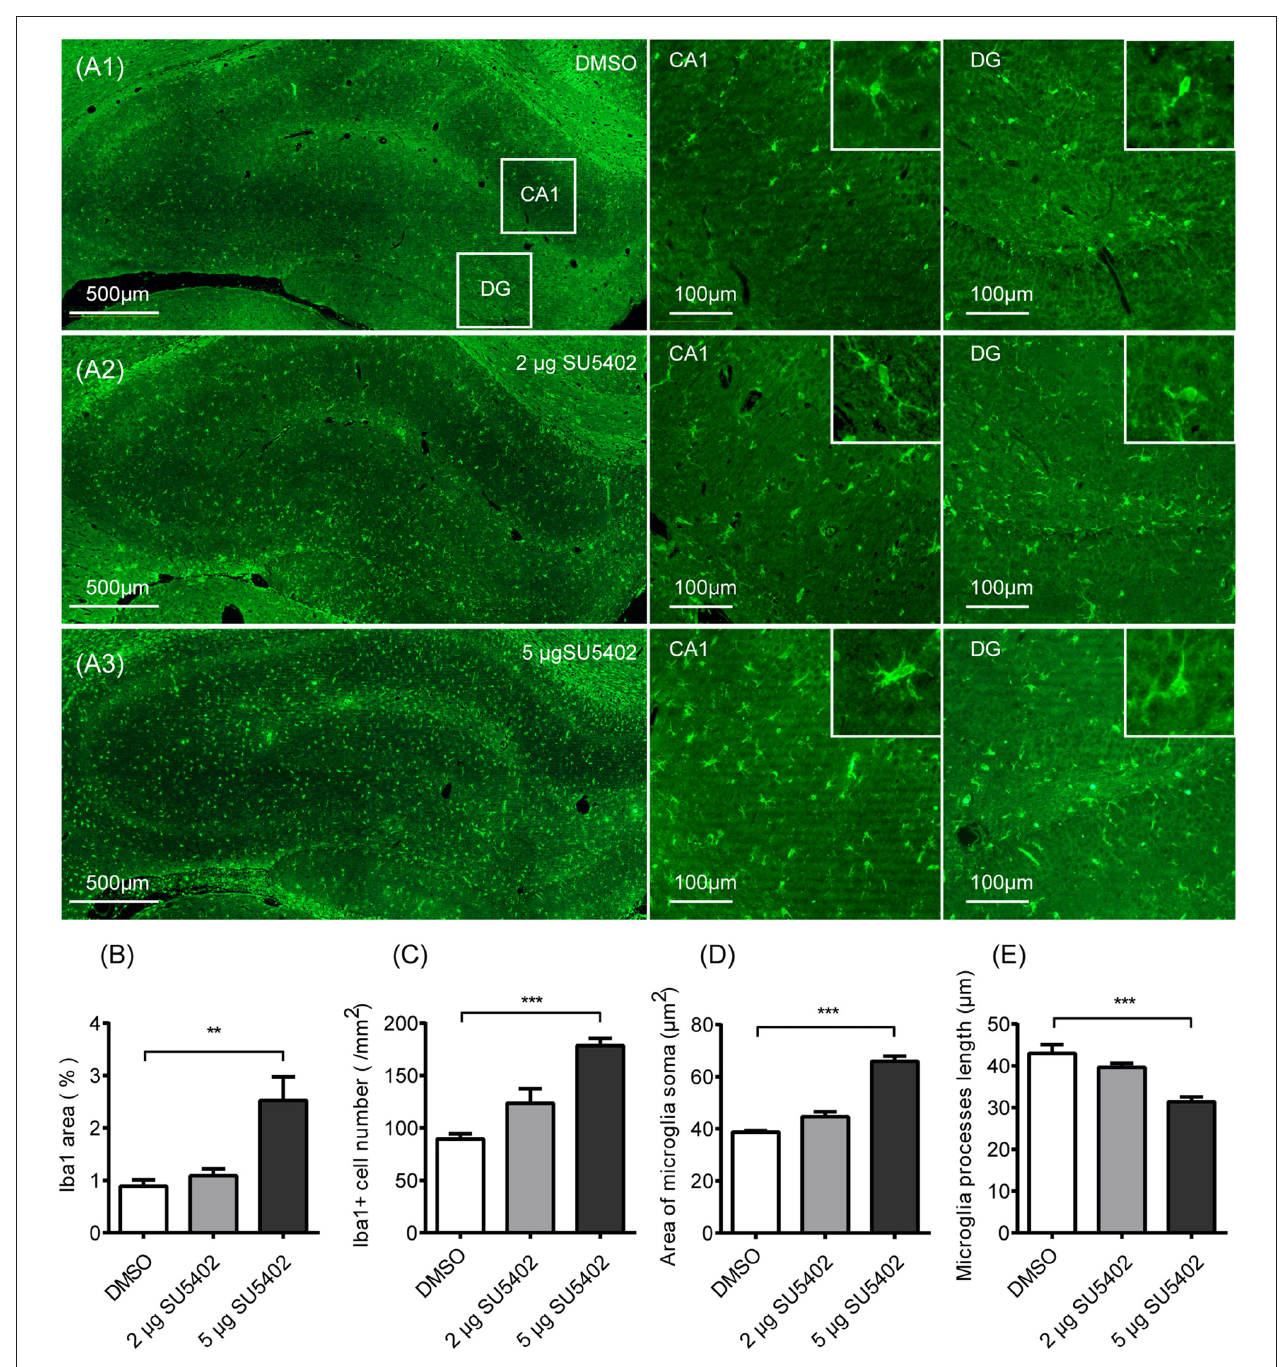
FIGURE 5 | Impact of FGFR inhibitor (SU5402) on the microglia activation in hippocampus. (A1–A3) Representative photographs of Iba1 expression in hippocampus. Compared with the DMSO group, there were increased expression of microglia identification marker Iba1 and more Iba1 positive cells in CA1 and DG with the swollen soma and retracted processes in 5 µ g dose of SU5402 group. (B) The percentage of Iba1 positive area was increased by 5 µ g dose of SU5402. (C) The density of Iba1 positive cells was increased by 5 µ g dose of SU5402. (D) The area of microglia soma was increased by 5 µ g dose of SU5402. (E) The length of microglial processes was decreased by 5 µ g dose of SU5402. One-way ANOVA with Dunnett’s multiple comparisons test, n = 4 per group. Data are presented as the means ± SEM. ∗∗ p < 0.01, ∗∗∗ p < 0.001. DMSO, dimethyl sulfoxide; DG, dentate gyrus.